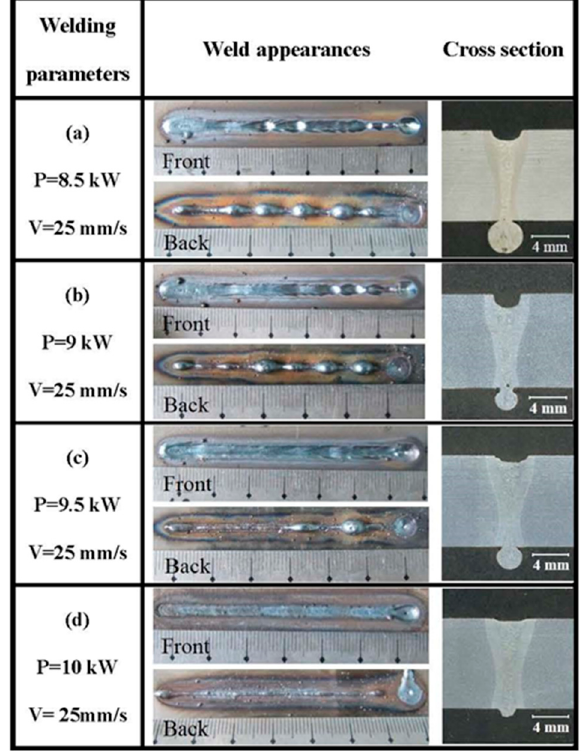
Figure 3. Weld appearances and cross sections of single-pass full-penetration laser-welded high- strength steel with various laser powers (P—laser power; V—welding speed).